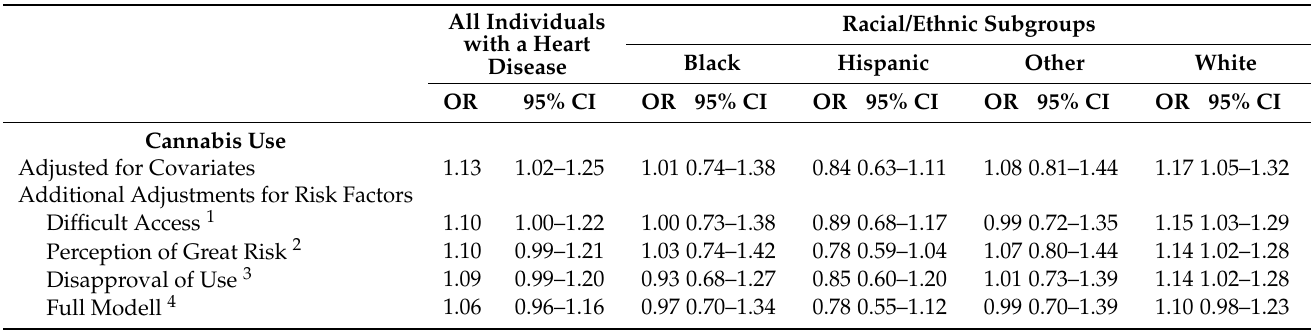
Table 4. Test of trends in cannabis use among adults with heart disease when cannabis-specific contexts of cannabis use were adjusted: pooled sample of NSDUH